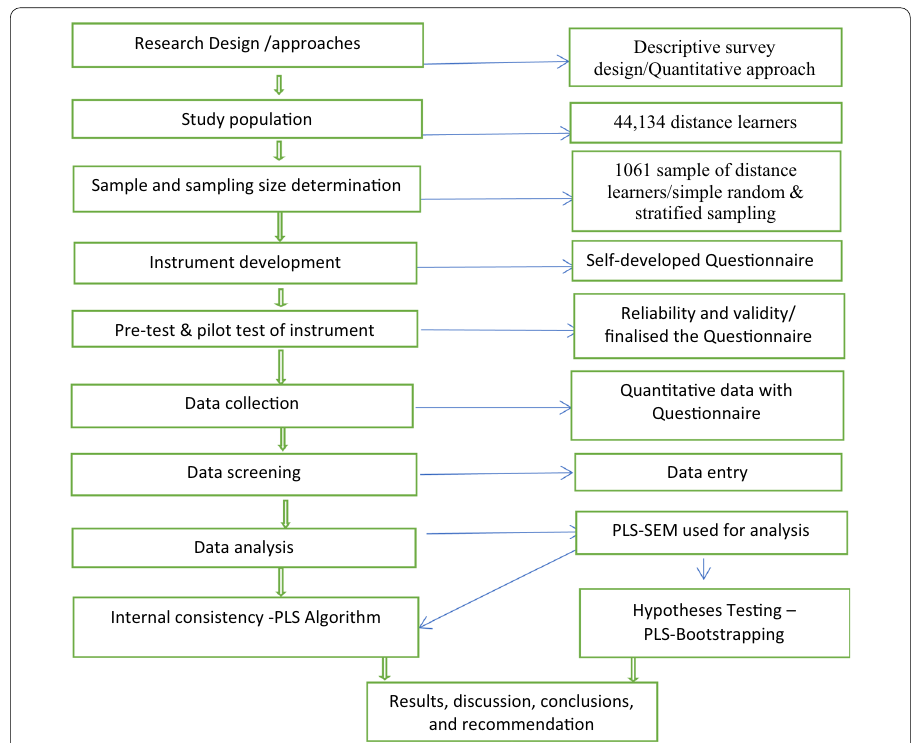
Fig. 2 The methodological process highlighting the various stages of